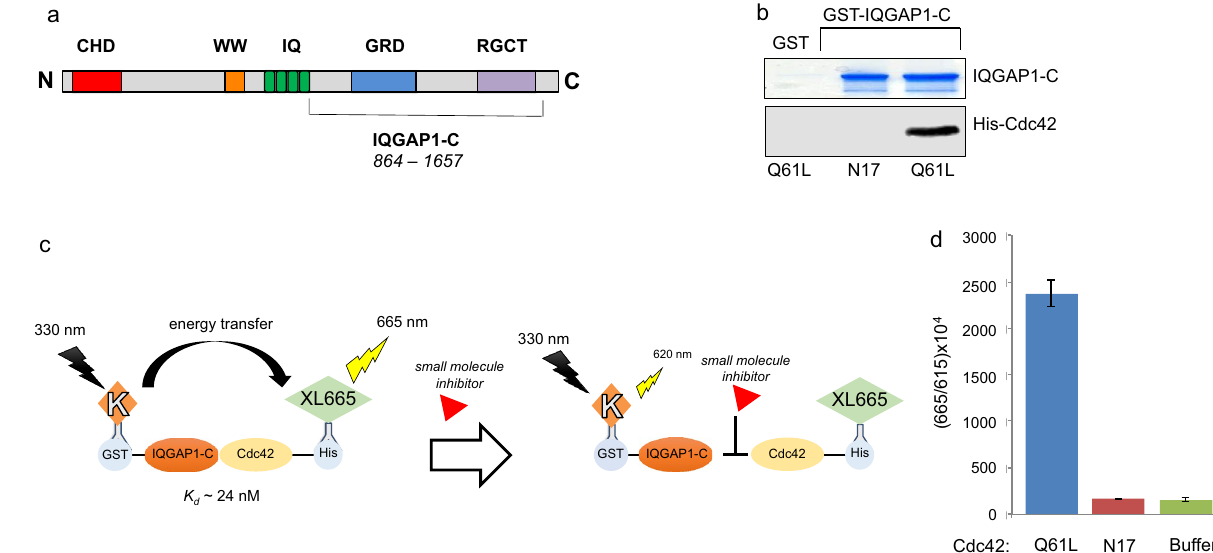
Figure 1. Detection of IQGAP1/Cdc42 complex formation. ( a ) Schematic representation of IQGAP1 protein. The C-terminal half of IQGAP1 (amino acids 864–1657) was used in the HTRF assay. ( b ) GST pull-down assay. GST-IQGAP1-C was incubated with His-tagged Cdc42-N17 or Cdc42-Q61L for 2 h at 4 °C. GST alone was incubated with Cdc42-Q61L as the negative control. Complexes were isolated using glutathione-Sepharose and resolved by SDS-PAGE. The gel was cut at 70 kDa. The upper part of the gel was stained with Coomassie blue. The lower portion of the gel was transferred to PVDF membrane and probed with anti-Cdc42 antibodies. ( c ) Scheme of the HTRF assay in 384–well format showing fluorescent labeled GST-IQGAP1-C (donor Europium cryptate, K) and His-Cdc42-Q61L (acceptor XL665). ( d ) Time resolved fluorescence was detected at 615 and 665 nm on the Biotek Synergy using recombinant proteins. The Y-axis represents the ratio of acceptor to donor emission wavelength multiplied by 10,000. The means and standard errors of two replicates are shown. The green bar (Buffer) indicates samples without